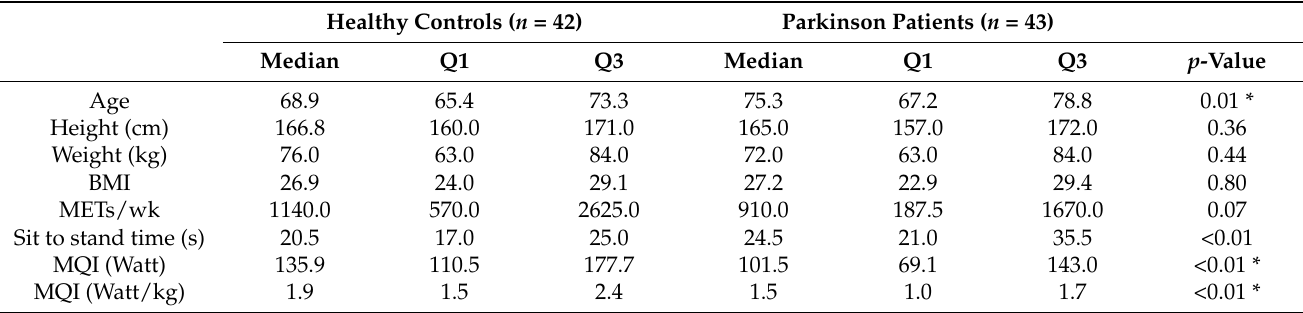
Table 1. Descriptive statistics and functional scores of healthy controls and Parkinson’s disease patients.